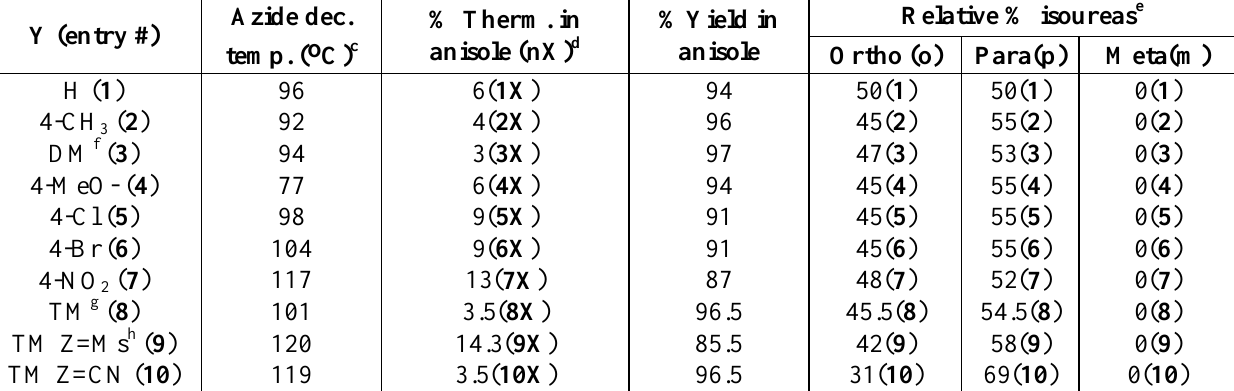
to Isoureas (Y-Ph-O-C=N-Z)- 3 Relative % isoureas e